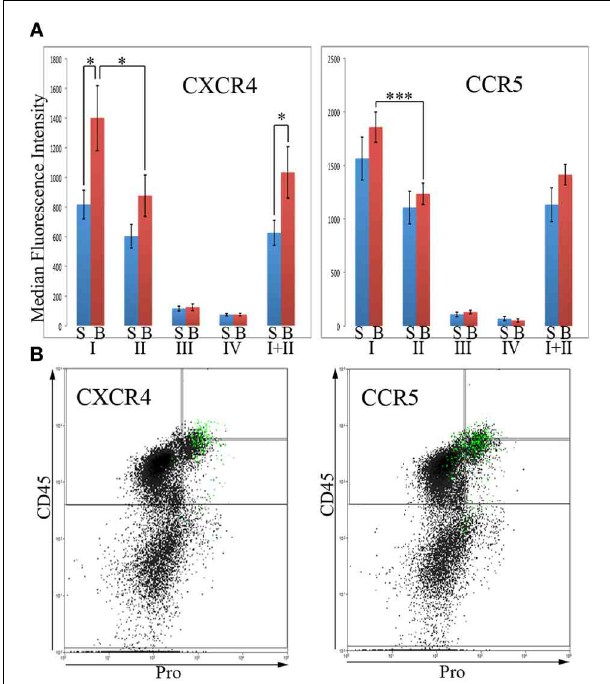
FIGURE 6 | Chemokines CXCR4 and CCR5 in Regions I–IV. (A) Total lung cells from saline- and bleomycin-treated mice sacrificed 28 days after initiation of treatment were immunolabeled for CD45, Pro, and either CXCR4 or CCR5. CXCR4 or CCR5 levels in Regions I–IV, and I + II are shown in terms of the average ± s.e.m. of the median fluorescence intensity of each of the following number of mice: CXCR4, 15 saline and 18 bleomycin; CCR5, 9 saline and 12 bleomycin. S, saline; B, bleomycin. (B) The 2% of the total lung cells with the highest levels of CXCR4 or CCR5 were selected and marked green. Scatter plots of CD45 on the y-axis vs. Pro on the x-axis showing these selected, green marked cells are presented. As noted in the text, the position of the green-marked cells is different for CXCR4 and CCR5. Similar results were observed in three independent experiments. ∗ p < 0 . 05, ∗∗∗ p < 0 .